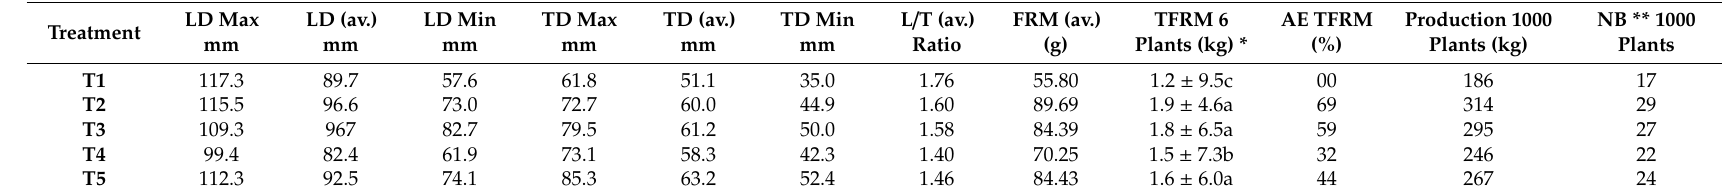
Table 4. Results of longitudinal diameter (LD), transverse diameter (TD), longitudinal vs. transverse ratio (L / T), fruit mass (FRM), average (av.) values per treatment; total fruit mass (TFRM), sum of 6 plants in each treatment; productivity (PROD) and number of boxes (NB), estimate of harvest per 1000 plants and agronomic e ffi ciency index (AEI) of total fruit mass, of 6 pepper plants.